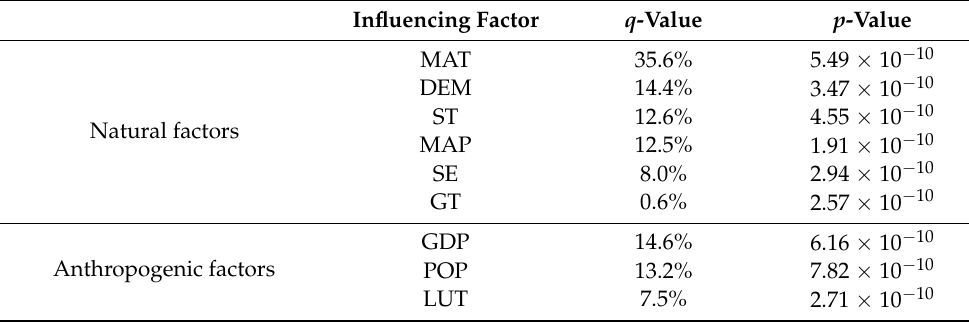
Table 2. The q -values of the factor